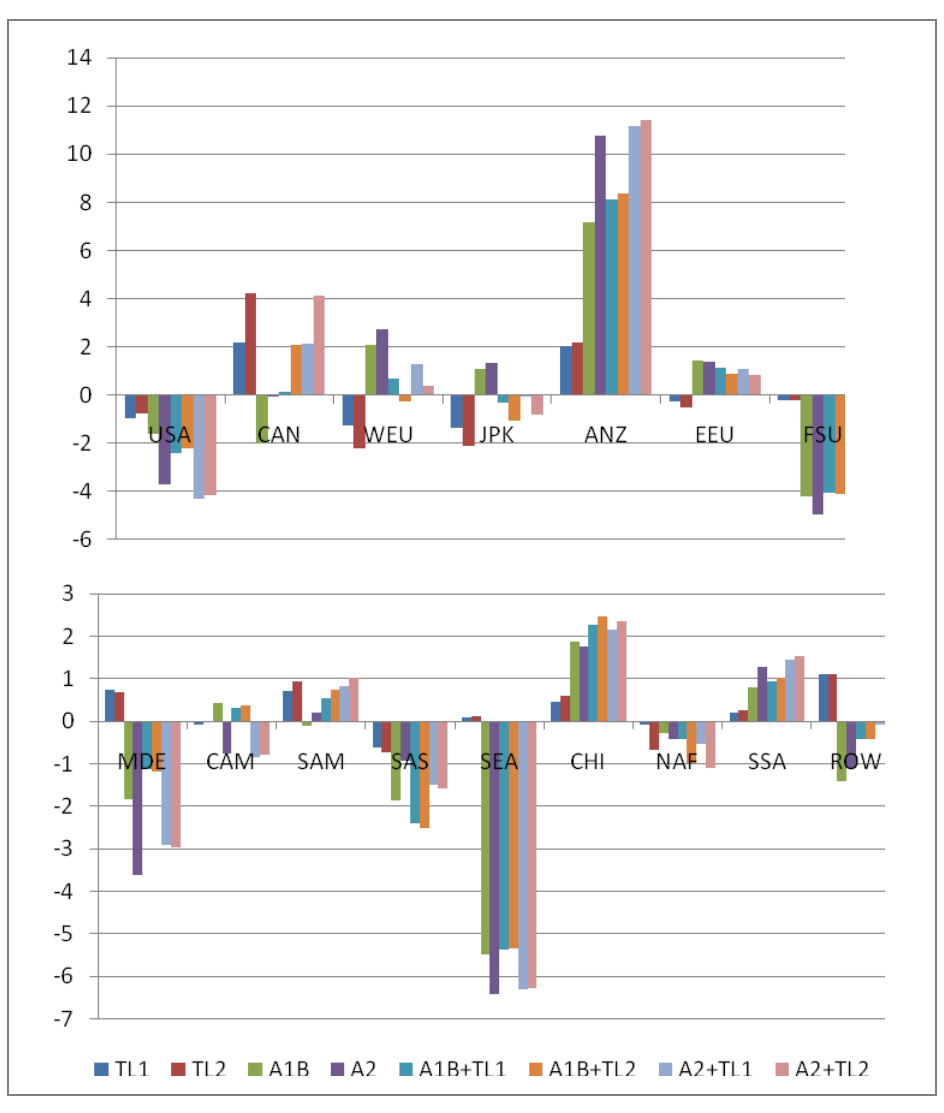
Figure 2. Change in agricultural production in 2020 (in %) relative to the baseline.